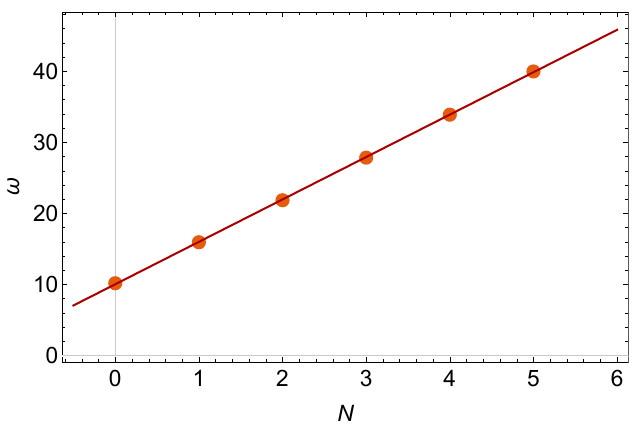
Figure 5 . The frequencies of modes with number N , and the linear (cid:12)tting function given in (6.30).